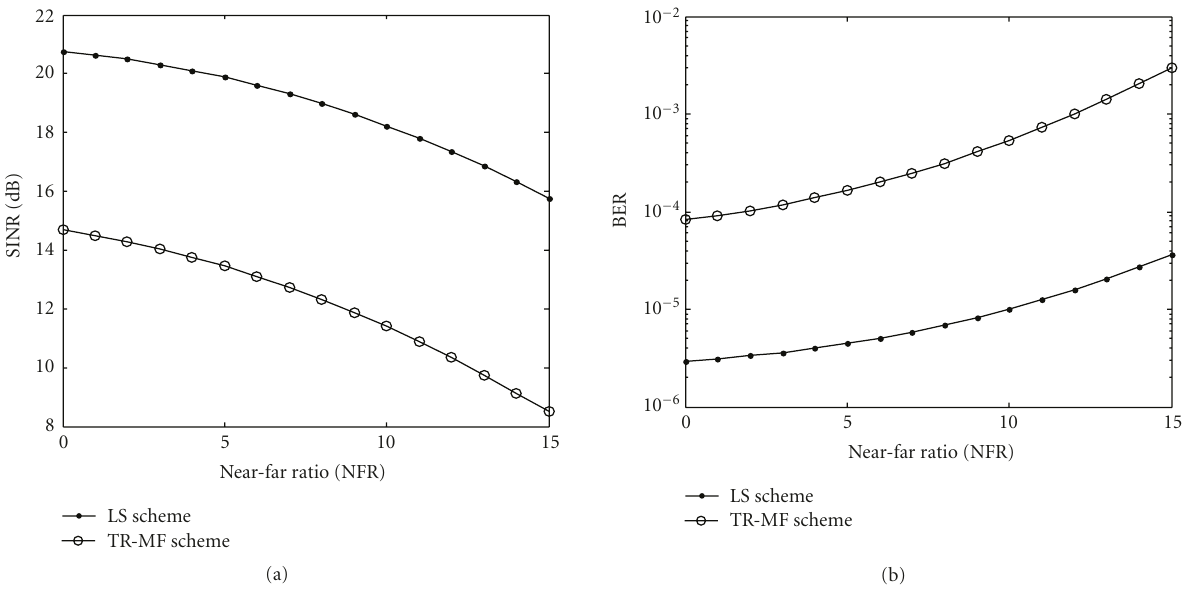
Figure 4: System performance with respect to near-far ratio (NFR) for the TR MF and LS schemes. (a) SINR performance with respect to the near-far ratio (b) BER performance with respect to the near-far ratio.